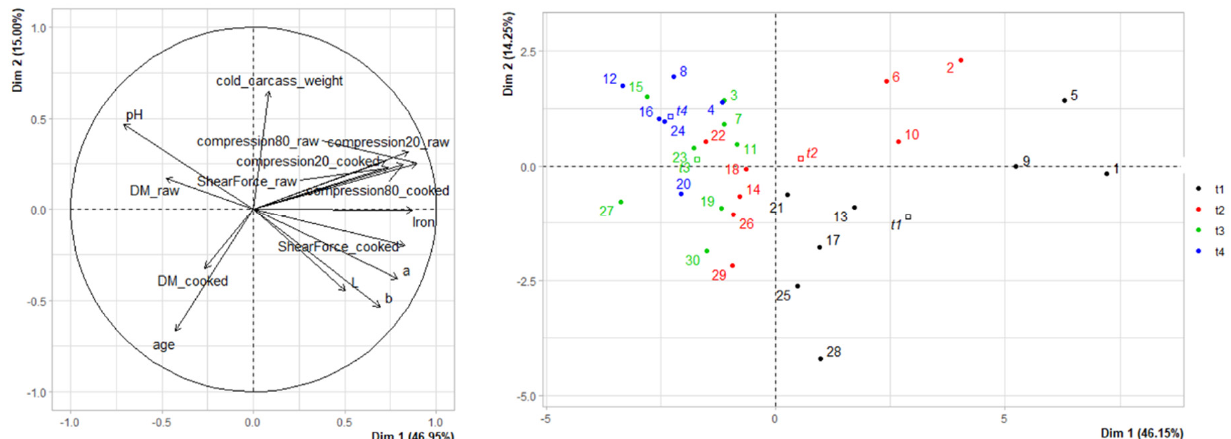
Figure 7. Correlation circle and projection of individuals for principal component analysis 1 per- formed on 4 × 8 = 32 samples. DM_raw, DM_cooked: Dry Matter on raw or cooked meat; Shear- Force_raw, ShearForce_cooked: Shear Force measurements on raw or cooked meat; Compression20, Compression80: Compression shear at 20% or 80% of the sample thickness; L, a, b: trichromatic colour coordinates L*, a*,